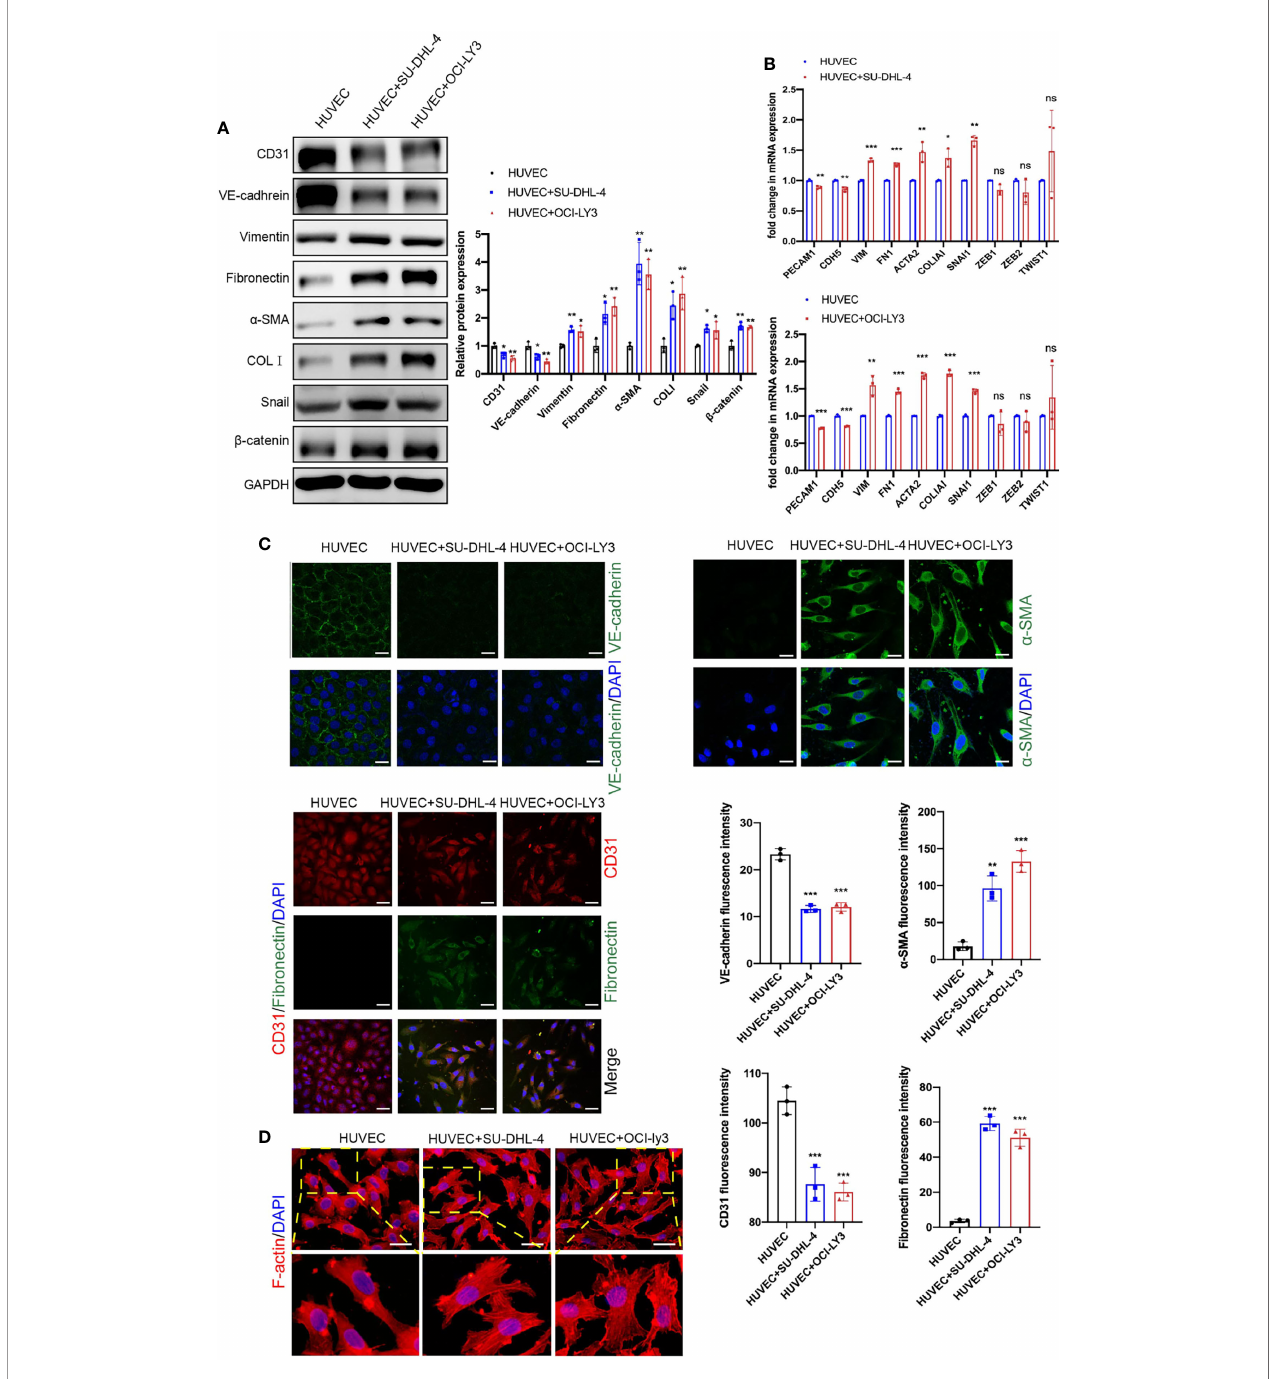
FIGURE 2 | Endothelial cells co-cultured with GCB and ABC DLBCL cells exhibited mesenchymal phenotype. (A) Protein expression changes of EndMT markers and b -catenin were detected by immunoblot (n = 3 independent experiments). (B) mRNA expression changes of EndMT markers were detected by qRT-PCR (n = 3 independent experiments). (C) Representative fl uorescence images showing downregulation of endothelial markers VE-cadherin (C1, green) and CD31 (C3, red) and upregulation of mesenchymal cell markers a -SMA (green, C2) and fi bronectin (green, C3) in HUVECs co-cultured with DLBCL cells. Nuclei were stained with DAPI. Scale bar, 25 m m; n = 3 independent experiments. (D) Representative fl uorescence images of skeleton changes in HUVECs by F-actin staining (n = 3 independent experiments). Scale bar, 25 m m. Error bars, SD; * p < 0.05, ** p < 0.01, *** p < 0.001 vs. control. ns, not signi fi cant; qRT-PCR, quantitative real-time PCR; GCB, germinal center B cell; ABC, activated B cell; DLBCL, diffuse large B-cell lymphoma; EndMT, endothelial-to-mesenchymal transition; HUVEC, human umbilical vein endothelial